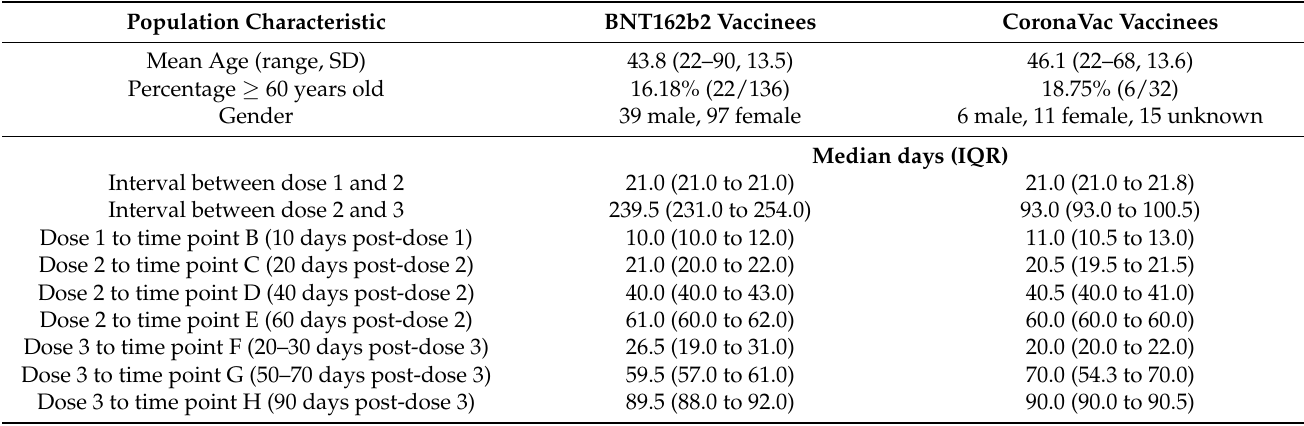
Table 1. Age and gender of study population and time interval between doses and sampling.